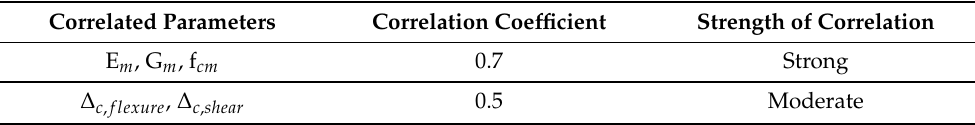
Table 2. Correlation coefficients between input